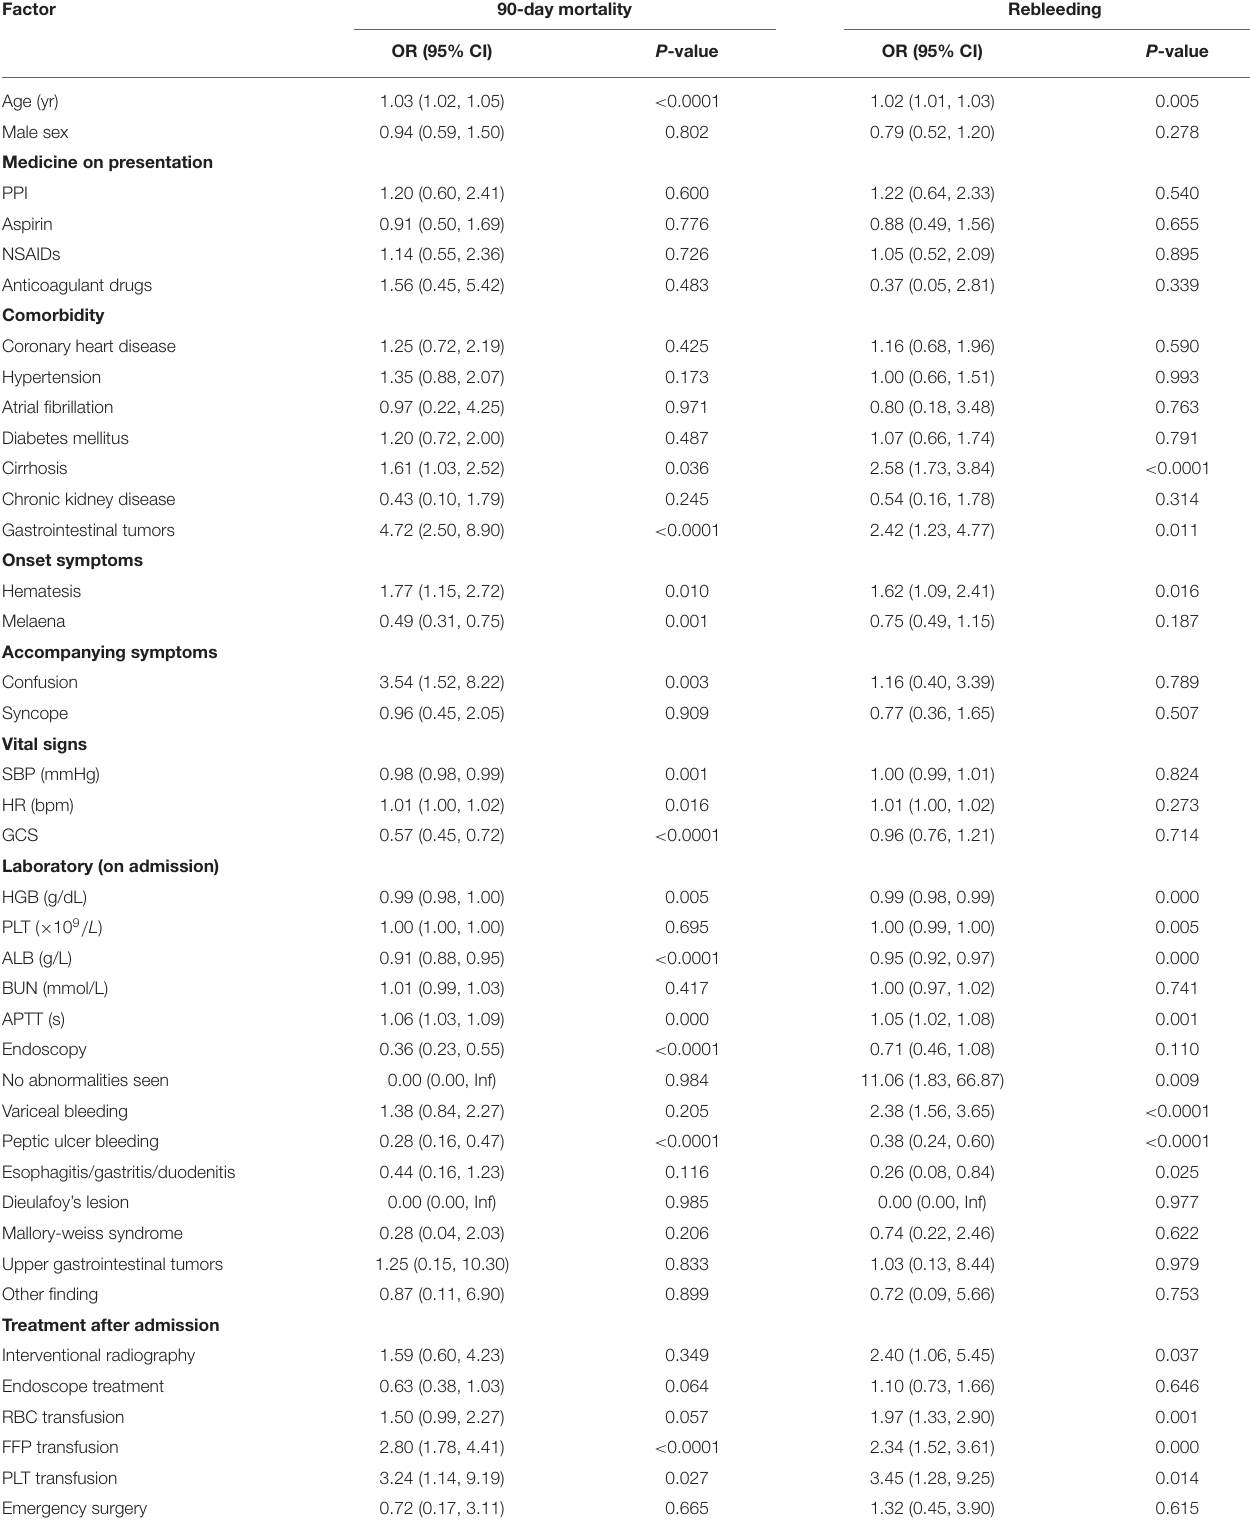
TABLE 2 | Univariate analysis of 90-day mortality and